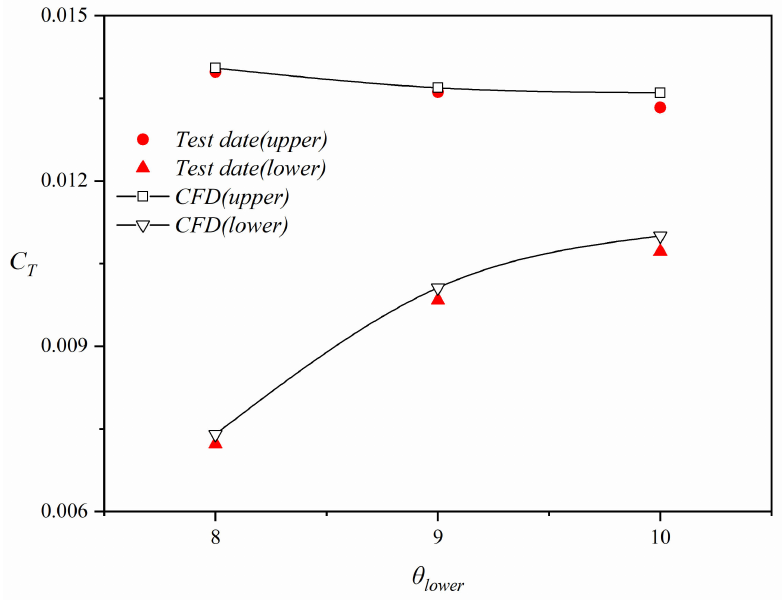
Figure 7. C T of the upper and lower rotors in forward flights.